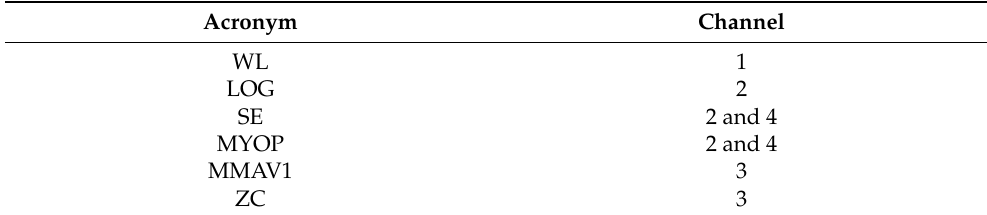
Table 11. Features selected as the best subset of characteristics for classifying signals from the right upper extremity using the Gaussian kernel.